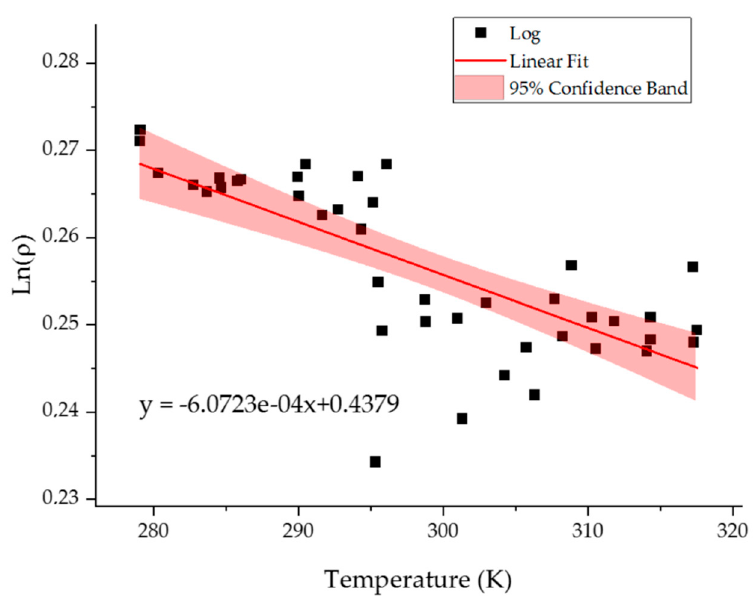
Figure 5. The dependence of Ln ρ on temperature. The red areas denote 95% confidence bands. The value of the slope is −6.0723 ∗ 10 (cid:2879)(cid:2872) ± 8.8 ∗ 10 (cid:2879)(cid:2873) (cid:2869) (cid:3012)